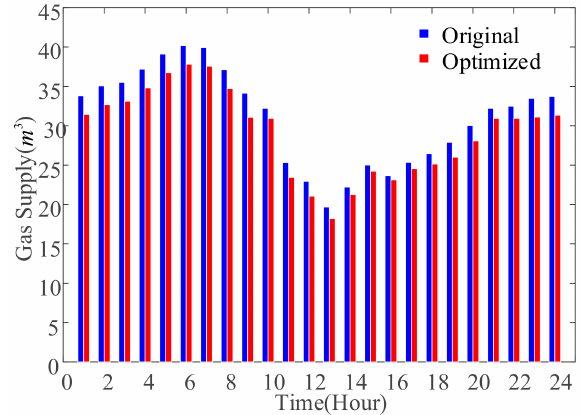
Figure 9. Natural gas consumption.